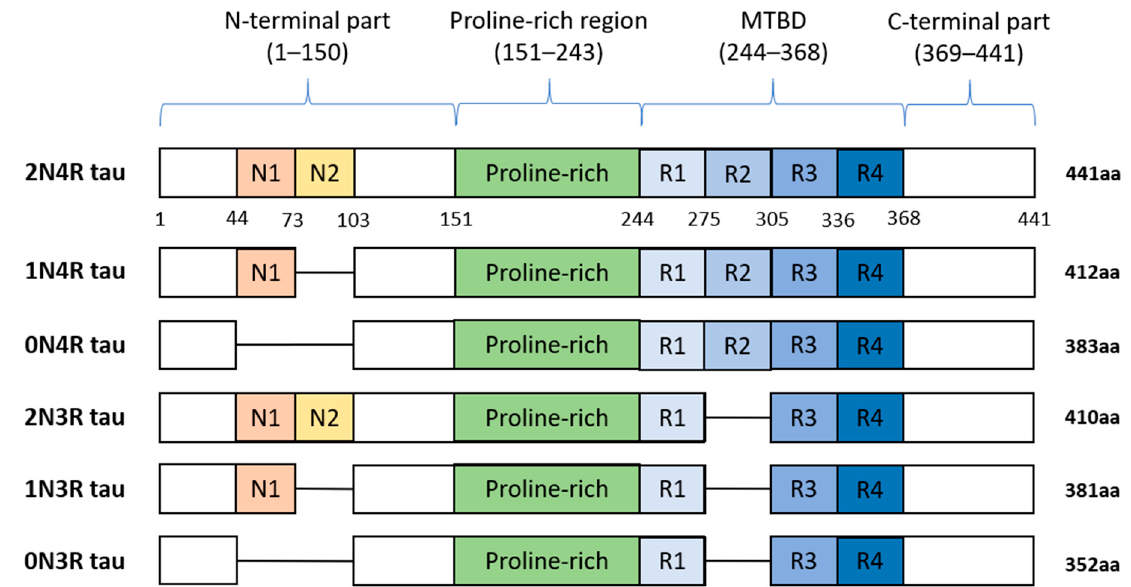
Figure 2. Schematic representation of six human tau protein isoforms and their domains. The N-terminal part is more acidic due to N1 and N2 inserts. The microtubule-binding domain (MTBD) is composed of repeats R1–R4. The number of repeats and N-terminal inserts varies according to the type of tau protein isoform.